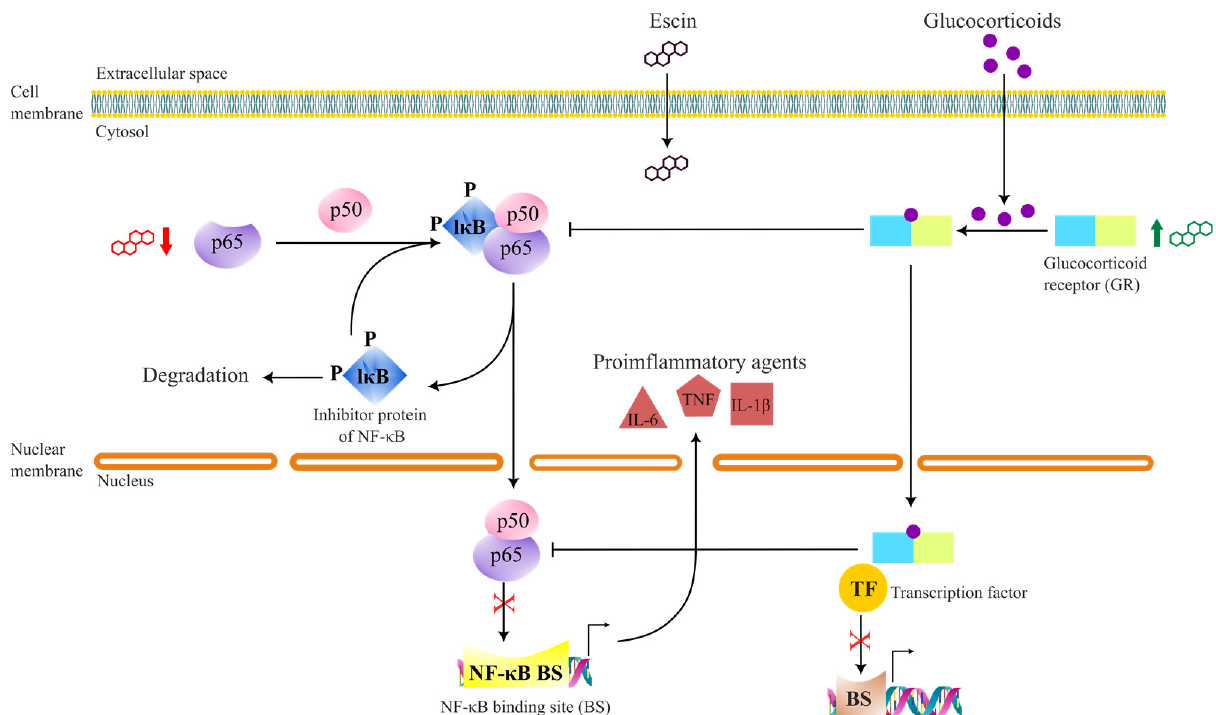
Figure 3. Overview of anti-inflammatory mechanisms of escin at the molecular level.